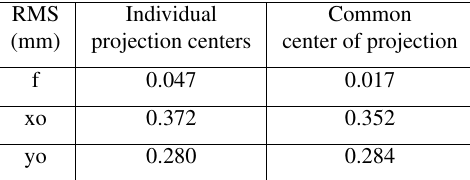
Table 1. Evaluation of accuracy by simulated data.